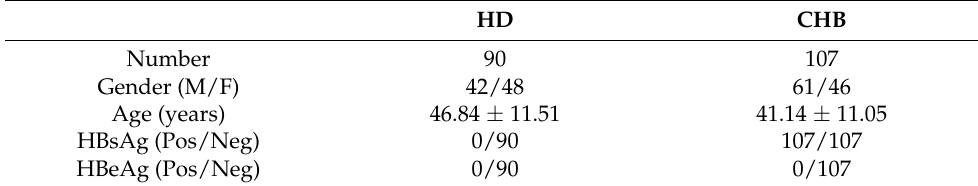
Table 1. Clinical data of healthy donors and CHB patients in the